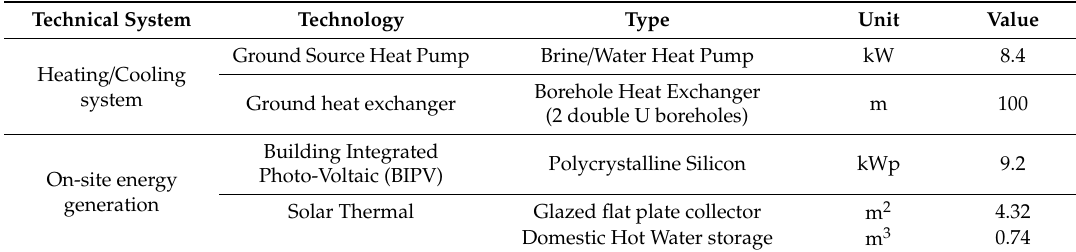
Table 2. Technical systems data.